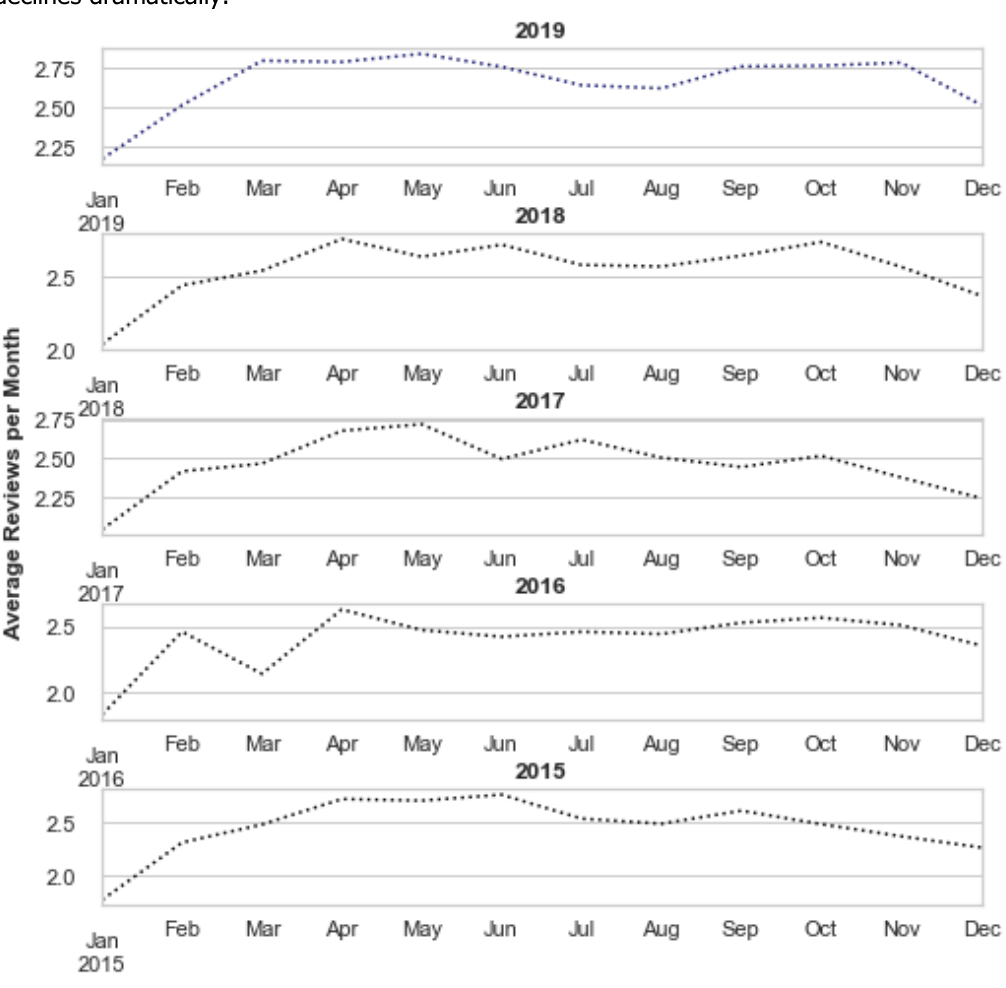
Figure 5. Average reviews per month for